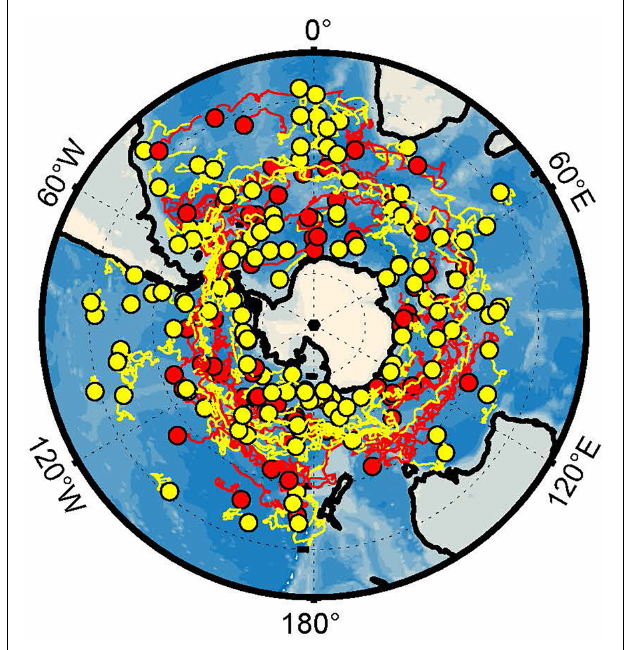
FIGURE 1 | Current location (circles) and associated trajectories (lines) from floats within the SOCCOM array, as of December, 2020. Both operational (yellow) and inactive (red) floats are